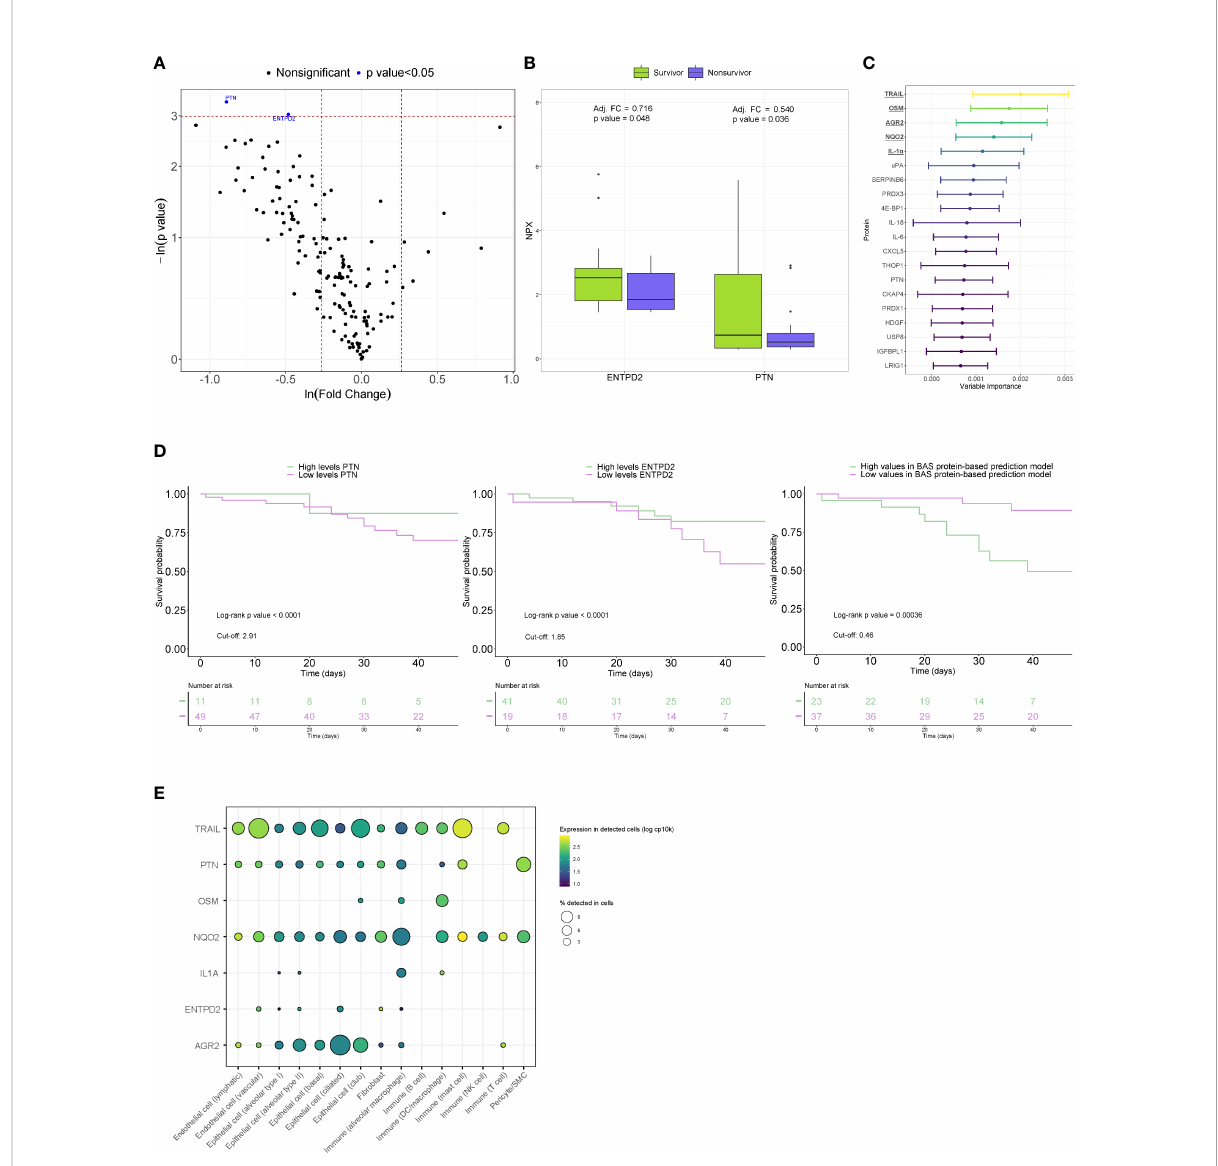
FIGURE 3 Proteomic biopro fi les of bronchial aspirates from survivors and nonsurvivors of ARDS secondary to SARS-CoV-2 infection. (A) Volcano plot showing the p value versus the fold change. Each point represents a detected protein. Blue dots represent the detected proteins that showed signi fi cant differences considering a p value<0.05. The association was adjusted by age. (B) Boxplot including bronchial aspirate proteins that showed differences between study groups. The adjusted fold change is displayed, and the signi fi cance level for each comparison is described by the p value. (C) Variable importance plot displaying the most relevant proteins according to their contribution to the random forest model. (D) Kaplan-Meier estimations for the individual proteins and BAS protein-based prediction model. Log-rank p values are displayed. (E) Cell enrichment analysis based on single-cell RNA-seq data from Genotype-Tissue Expression (GTex). Each row represents a protein, and each column represents a cell type. The color of the point shows the expression levels in detected cells, and the size of the point indicates the percentage of cells in which the expression was